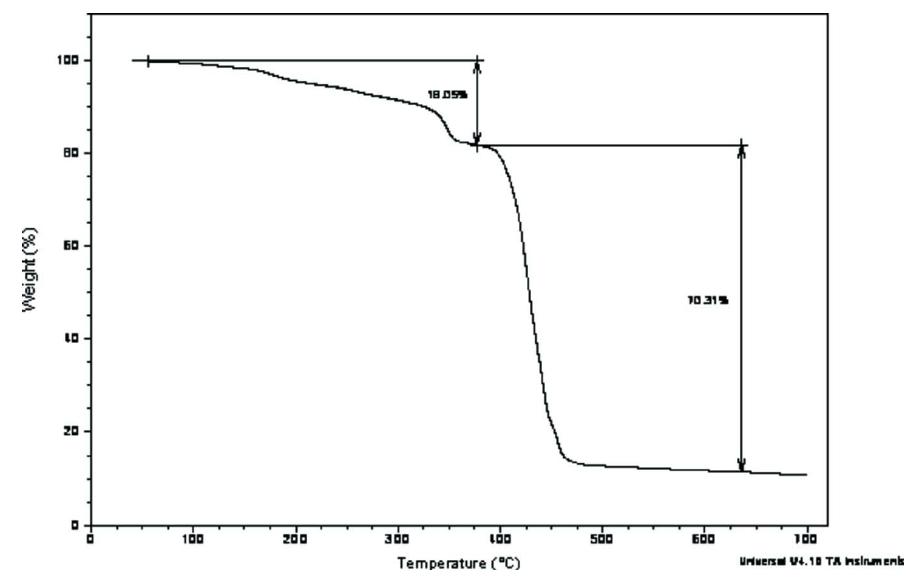
Figure 4 The TG-curve of the thermal decomposition of the title compound (I).